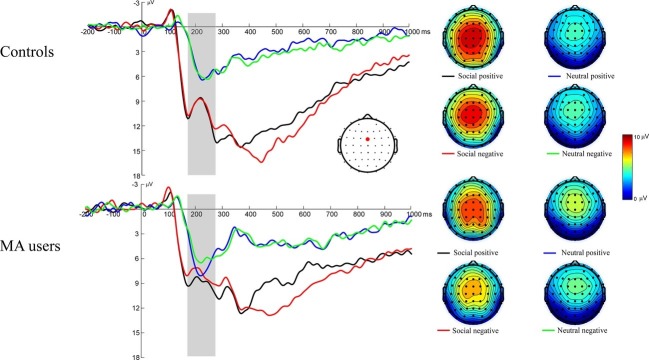
Left: FRN responses to social positive, negative feedback on SID. Feedback onset was at 0 ms. The FRN was scored as the average activity in the shaded window (175–275 ms). Right: The scalp distributions of the ERP responses to positive and negative feedback on SID.